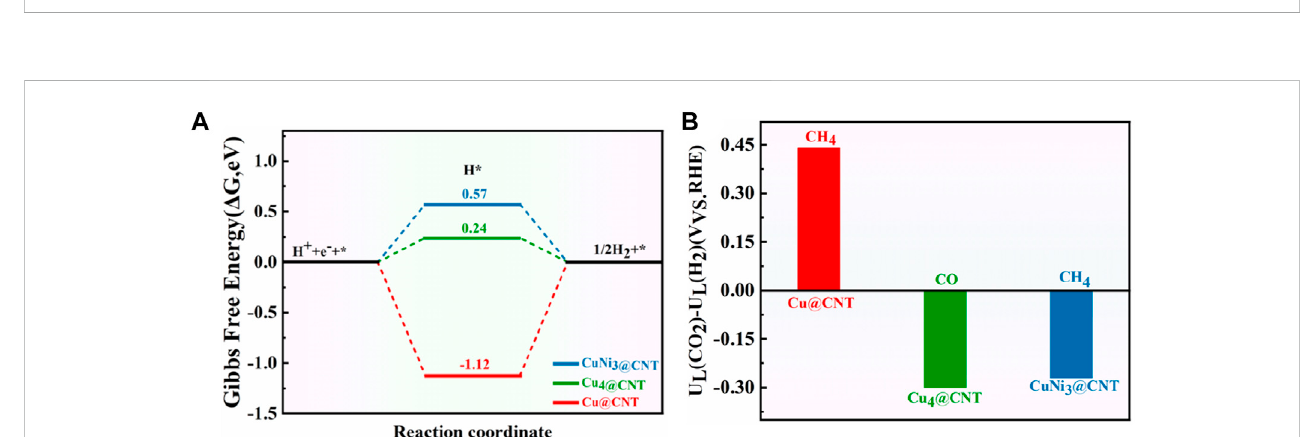
FIGURE 10 (A) Free energy diagram of theHER on Cu@CNTs, Cu